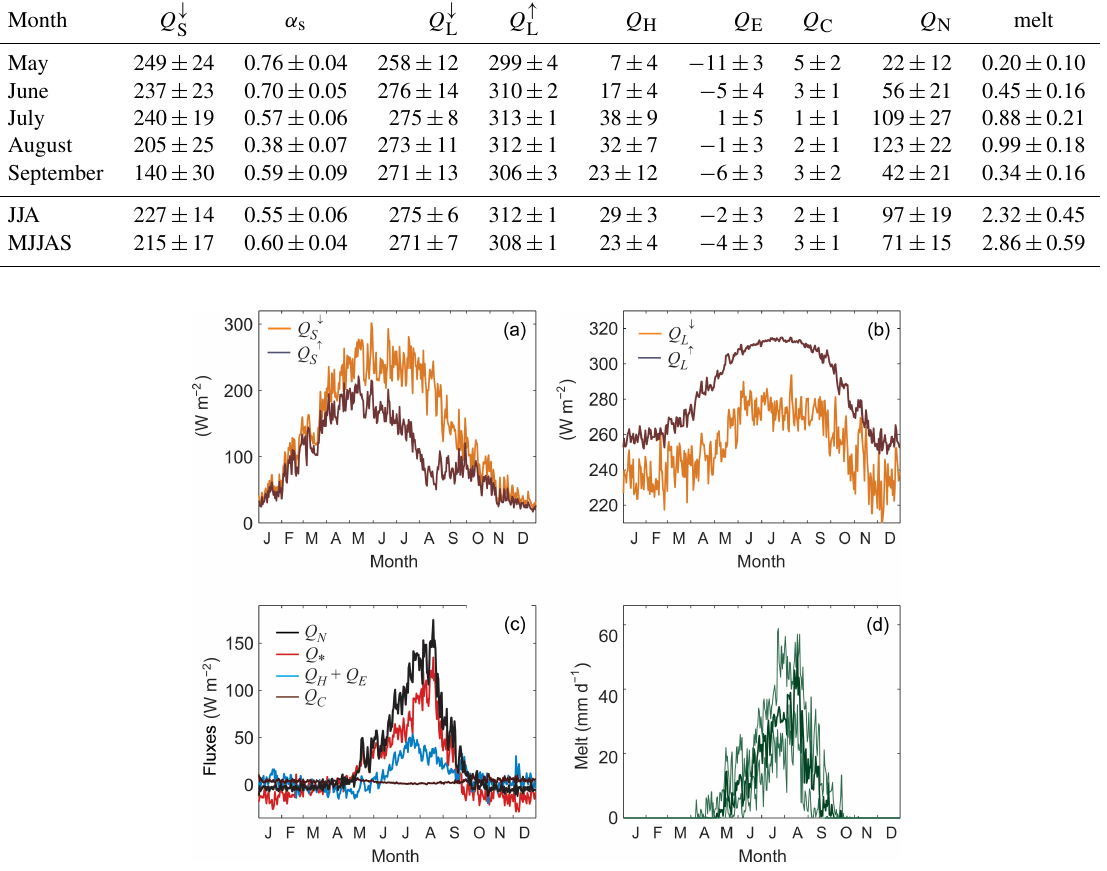
Figure 4. The average annual cycle of (a – c) surface energy fluxes and (d) daily melt at the Haig Glacier AWS. Daily mean values are plotted for the period 2002–2012. For melt rates, the heavy line is the median value and the thin lines indicate the interquartile